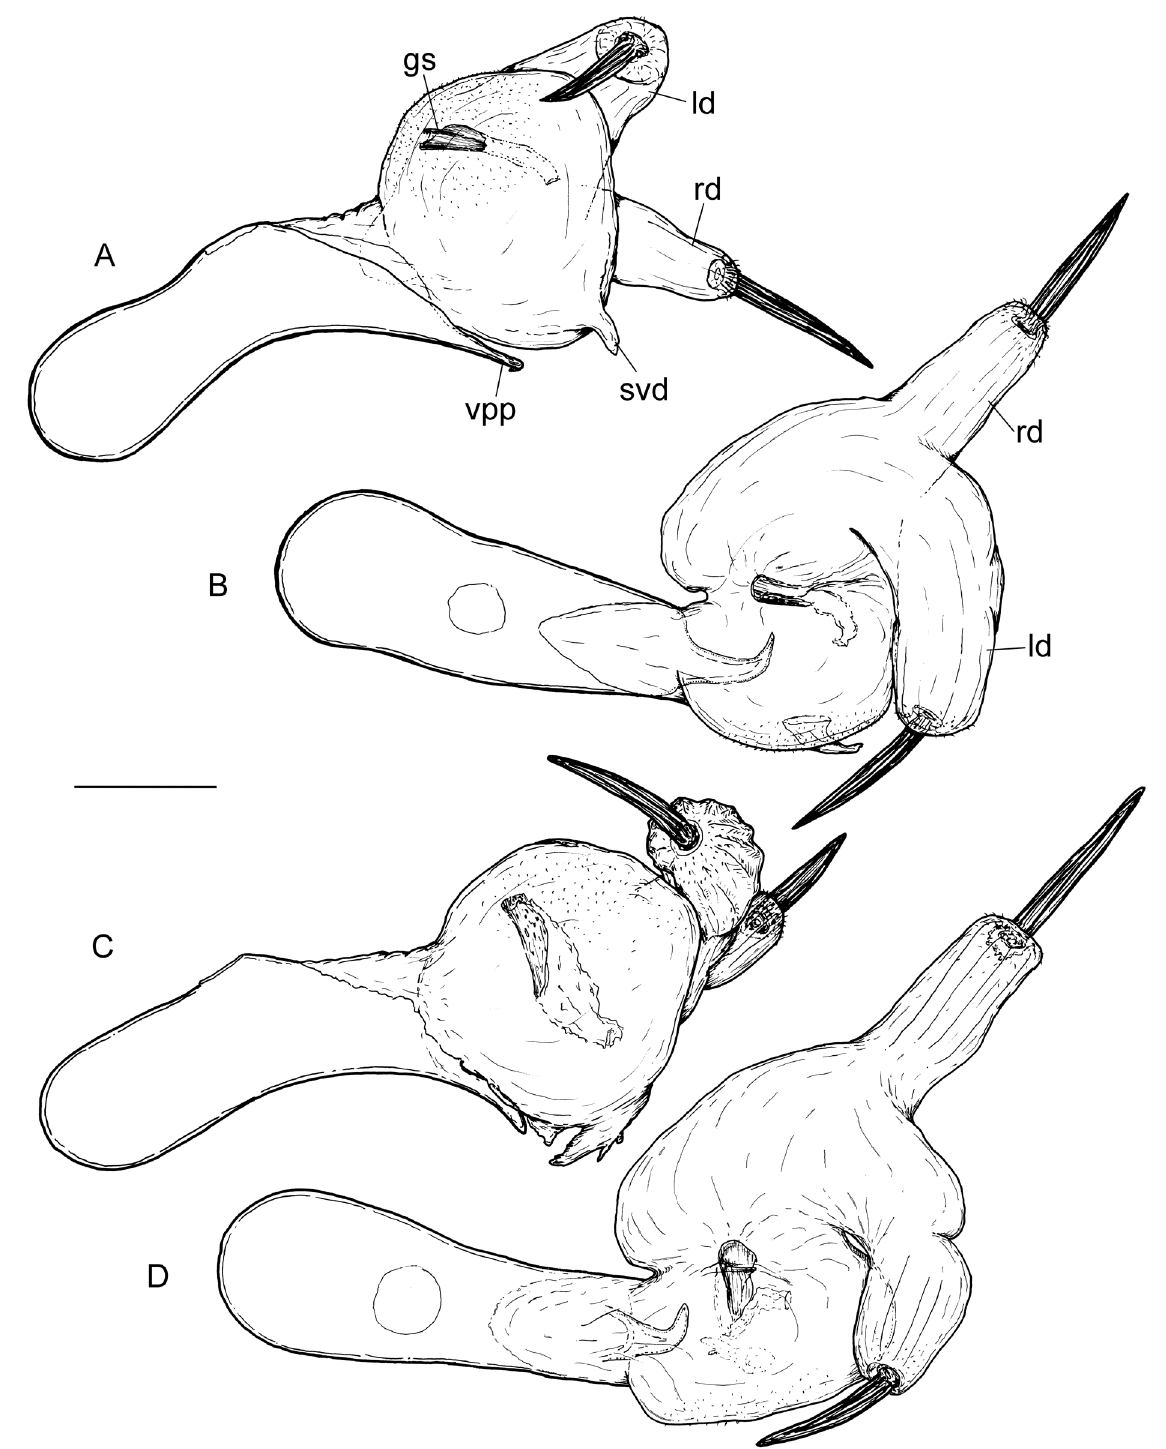
Fig. 5. Phalli with vesica everted, Phtheochroa schawerdae (Rebel, 1908) comb. nov. A–B . Bulgaria, Rila Mts. – C–D . Republic of Macedonia, Korab Mts. A, C: left. B, D: dorsal. Abbreviations: gs = gonopore sclerotization; ld = left diverticulum; rd = right diverticulum; svd = small ventral diverticulum; vpp = ventral phallic process. Scale bar = 250